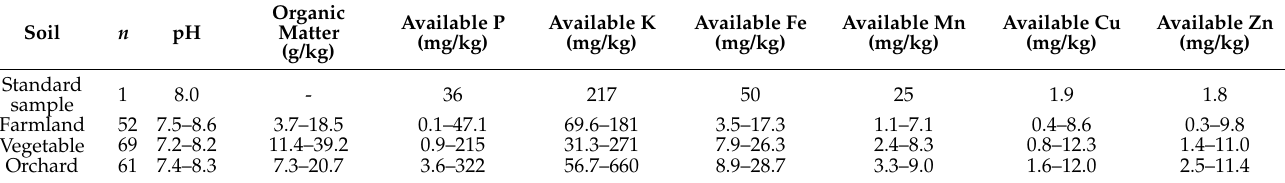
Table 1. The basic soil physical and chemical properties of collected soil samples.